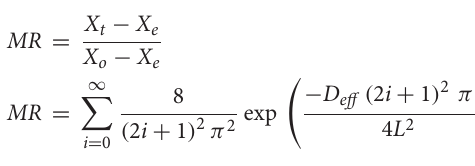
according to the following criterion, (X t + X t + 1 ) < 0.001, where X t + 1 is the moisture content at time t + 1 (Togrul and Pehlivan,